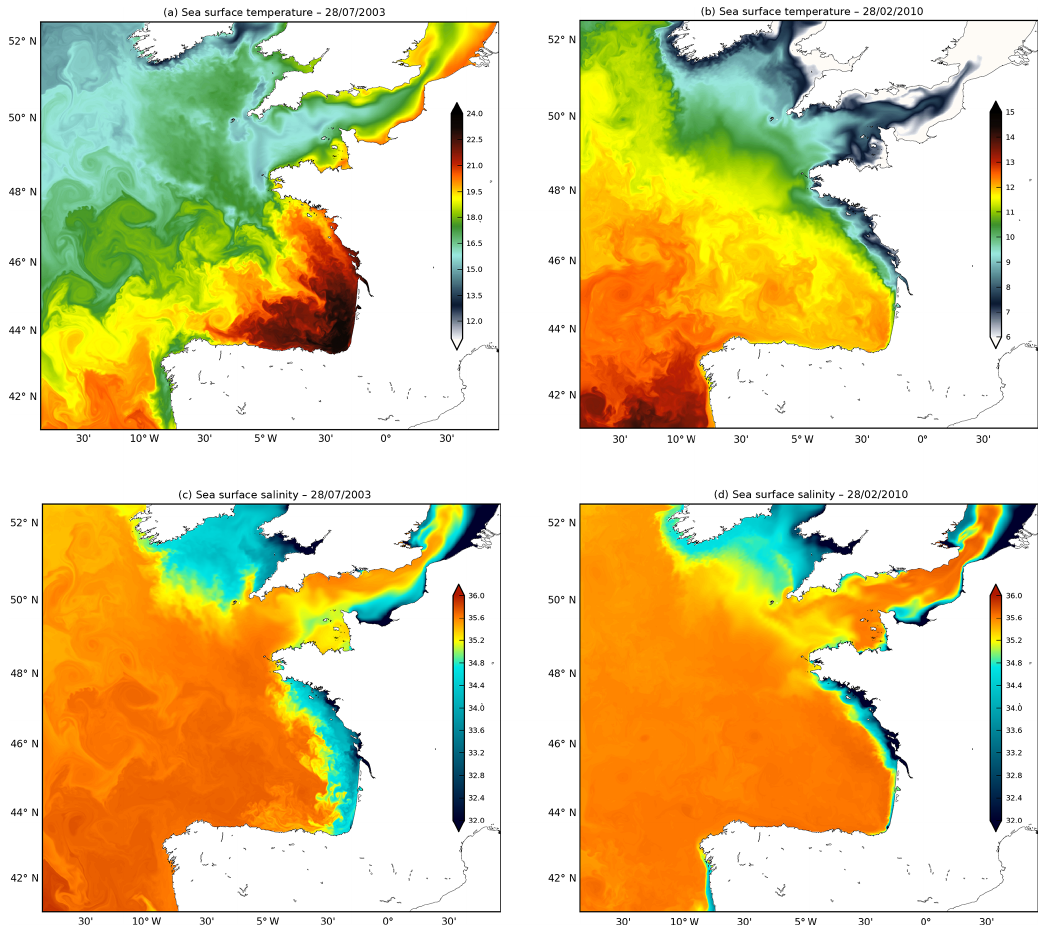
Figure 3. Example of modelled (BACH1000_100lev configuration) sea surface temperature (a, b) and salinity (c, d) in summer ( a, c – 28 July 2003) and winter ( b, d – 27 February 2010).